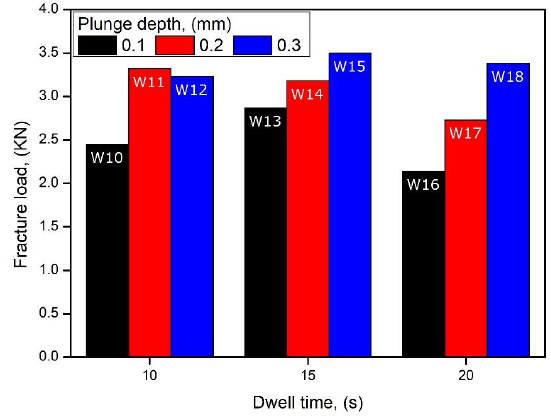
Figure 9: Tensile-shear load as a function of dwell time under differ- ent plunge depth for P-FSSW joints welded with Cu